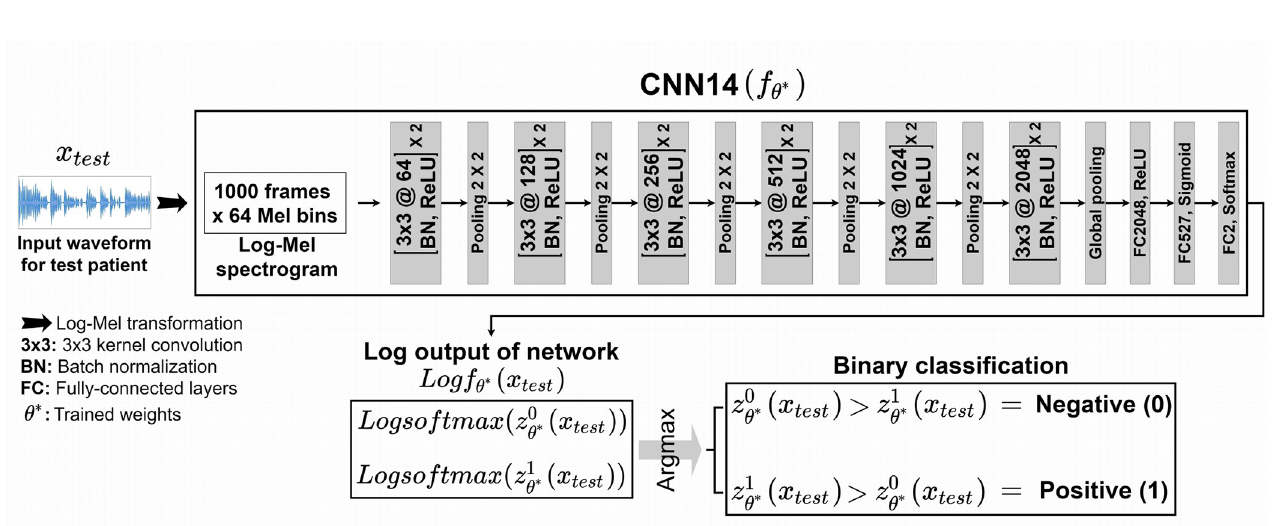
Fig 3. The log-Mel spectrogram of the waveform according to the selected dysarthria types (no evidence of dysarthria, hypokinetic dysarthria, and ataxic dysarthria) for each autumn and number protocol.